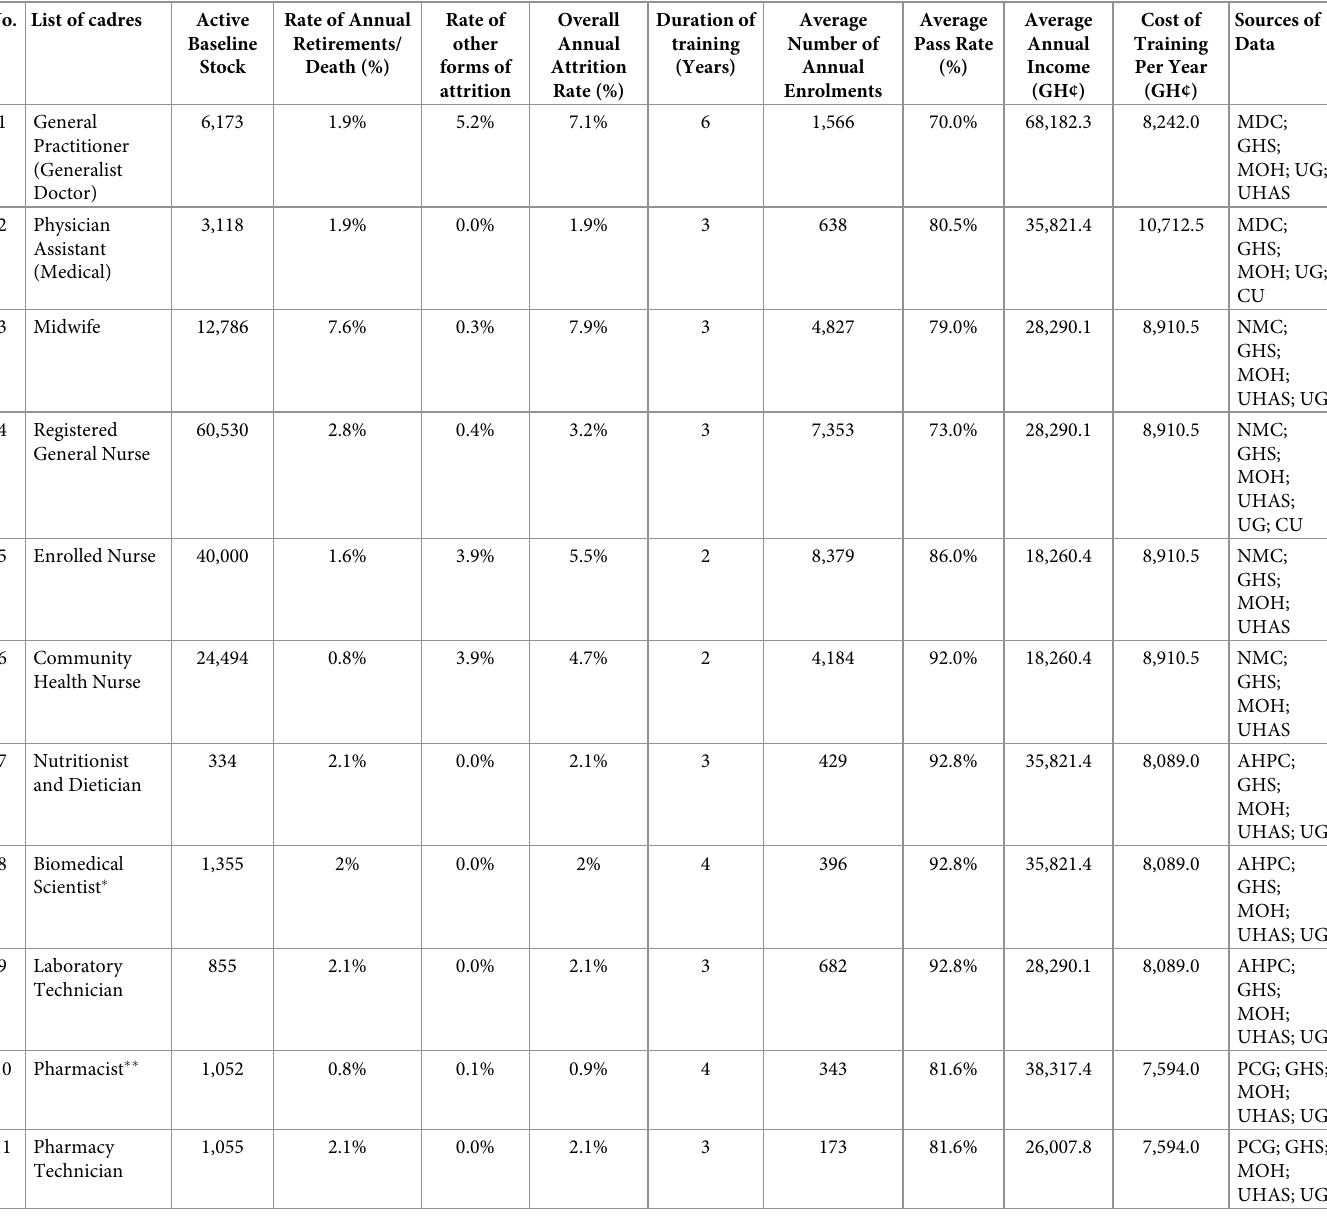
Table 1. Baseline stock, labour flows, training outputs, average income levels and cost of training. No. List of